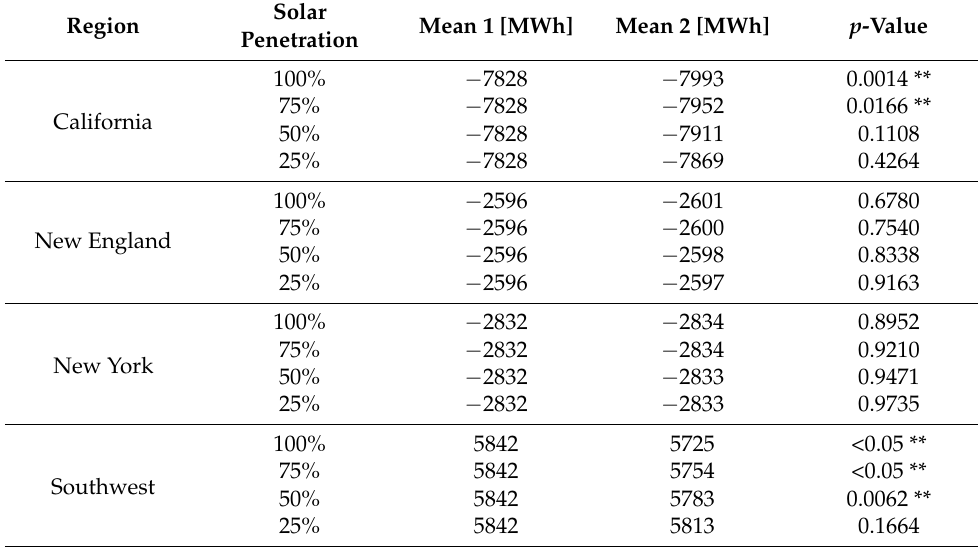
Table 8. Hypothesis 2— t -test results by region and level of solar penetration. Solar Mean 1 [MWh] Mean 2 [MWh] p Region Penetration